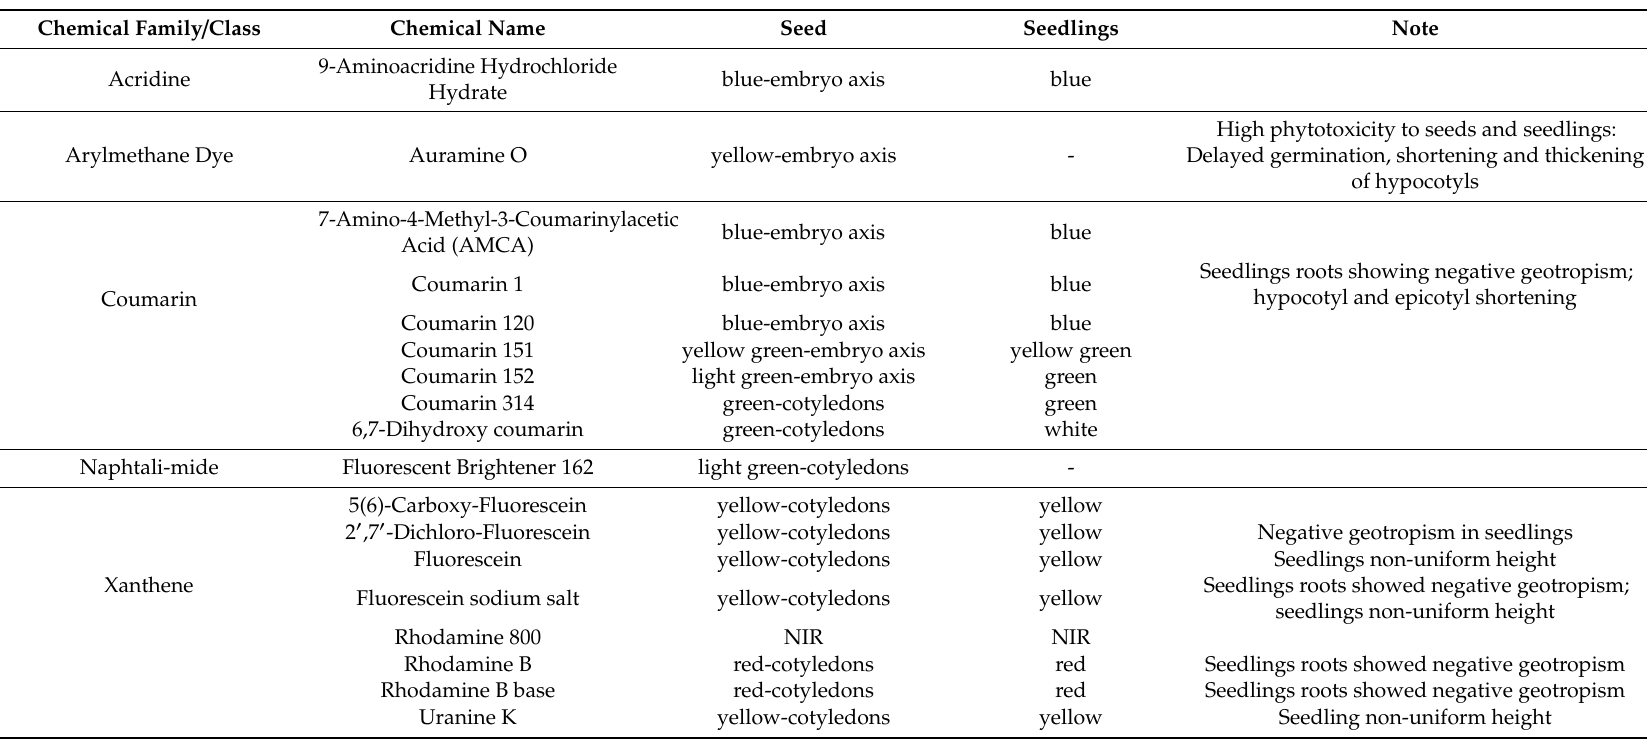
Table 3. Fluorescent chemical family / class, chemical name, and seed and seedling response from the application of tracers taken up by seeds and